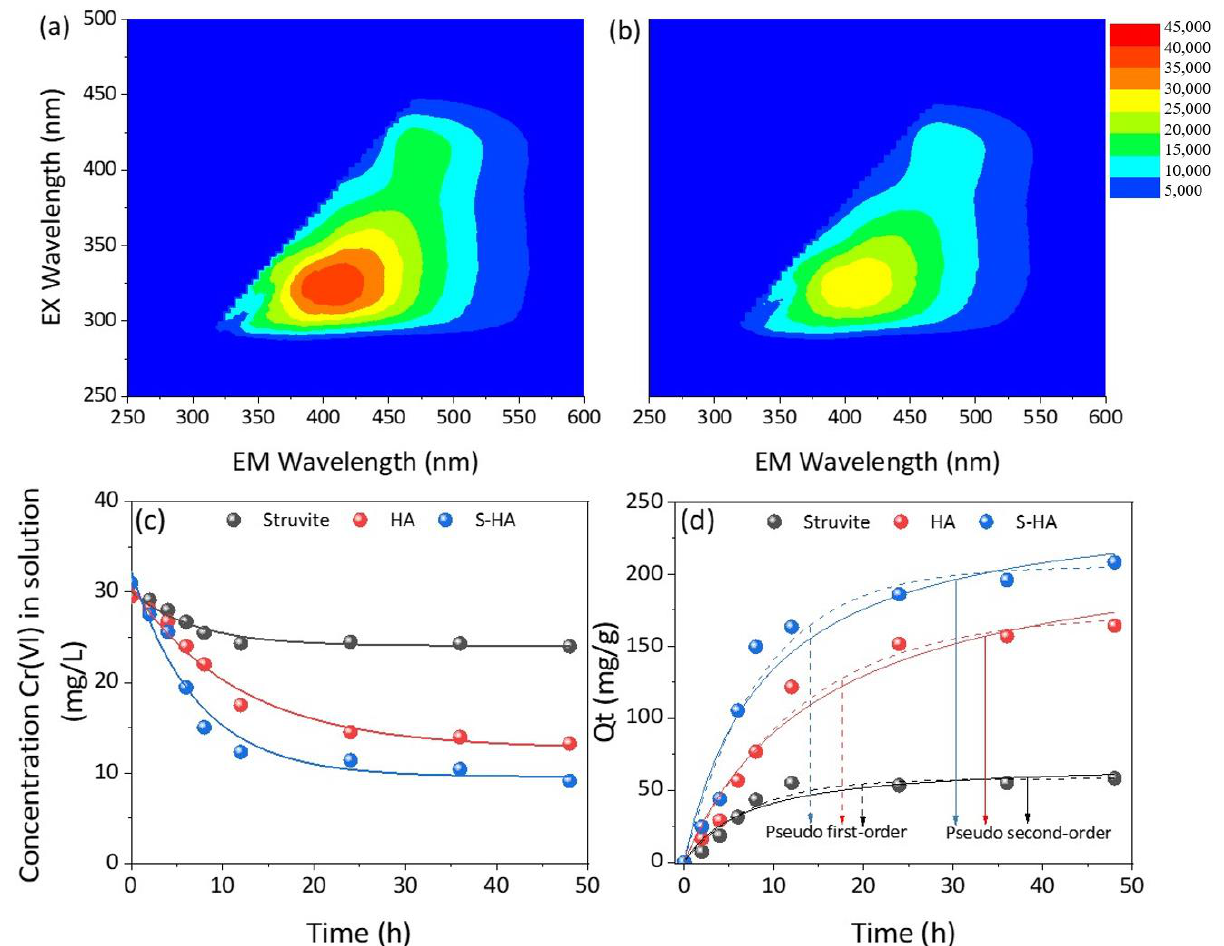
Figure 3. The excitation – emission matrix (EEM) spectra of the ( a ) struvite-coated humic acid without Cr(VI) and ( b ) with Cr(VI); ( c ) concentration variation of Cr(VI) adsorbed on struvite, humic acid, and struvite – humic acid composite; and ( d ) fitted curves showing pseudo second-order kinetics of struvite, humic acid, and struvite – humic acid composite (HA: humic acid; S – HA: struvite – humic acid composite).